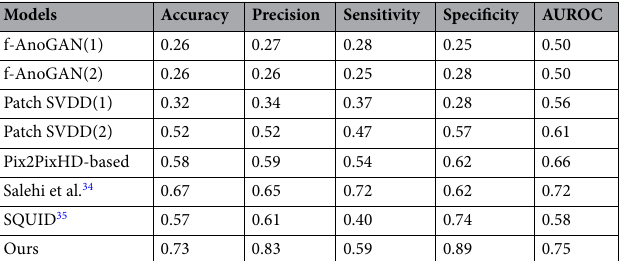
Table 4. Comparison of the performances of the proposed method with state-of-the-art methods for anomaly detection in CXR images.